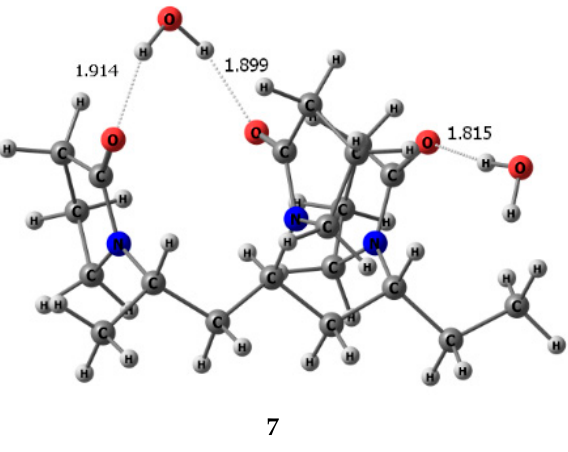
Figure 7. Optimized geometry of the VP-VP-VP copolymer moiety with 2 water molecules.